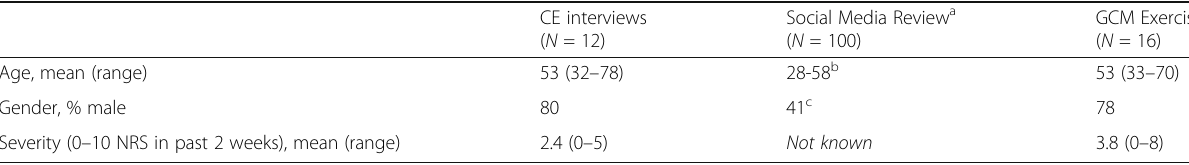
Table 3 Demographic results